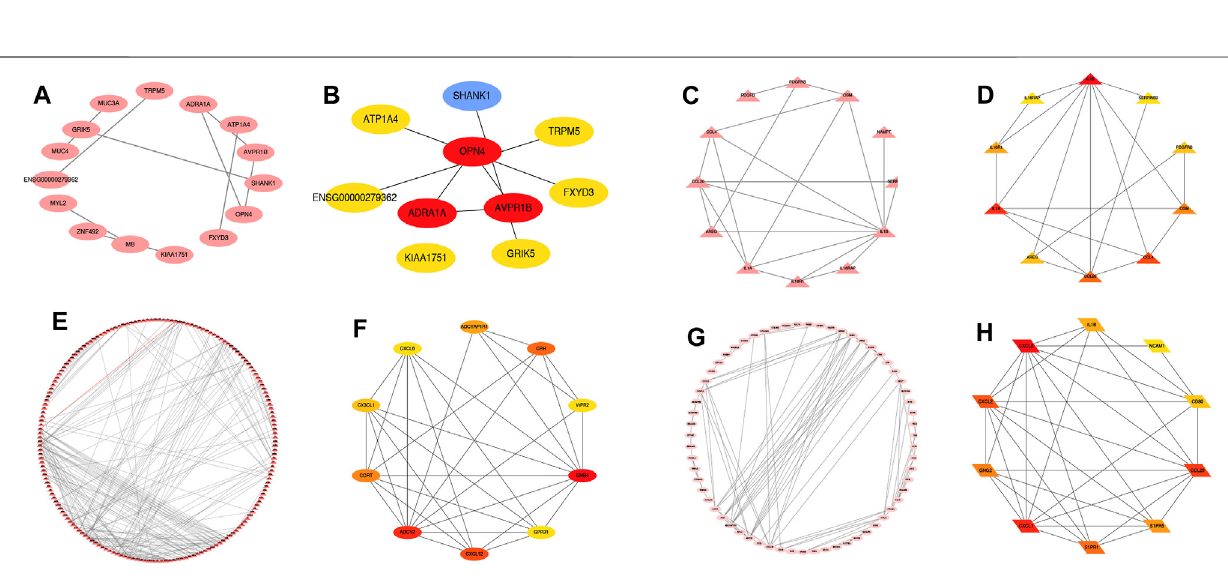
FIGURE 5 | Differential genes and up- and down-regulated messenger RNAs after intersection constructed for protein-protein interaction-HUB analysis. Differentially up-regulated, differentially down-regulated, differentially up-regulated after intersection, differentially down-regulated after intersection gene ( Figures 5A – H );differentiallyup-regulatedhubgene( Figures5A,B );differentiallydown-regulatedkeyhubgene( Figures5C,D );differentiallyup-regulatedafterintersectionhub gene ( Figures 5E, F ); differentially down-regulated hub gene after intersection ( Figures 5G, H